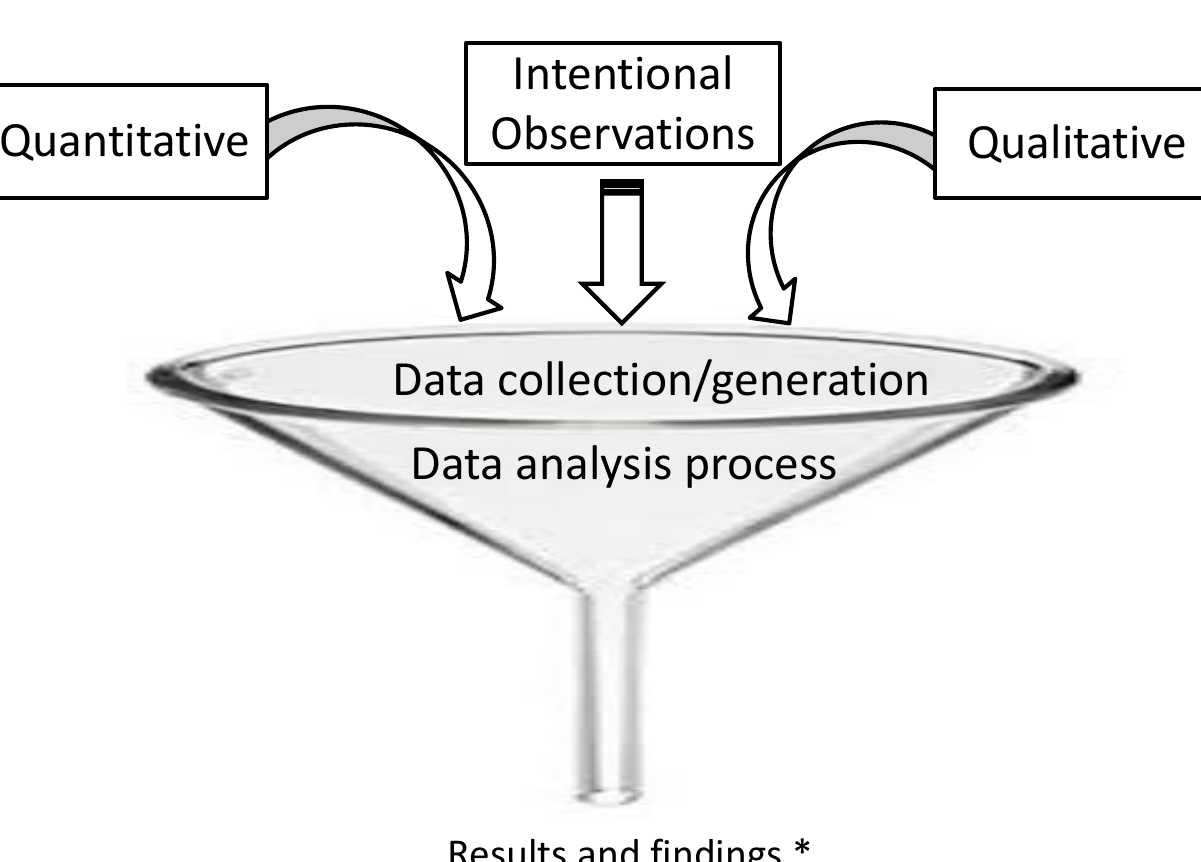
Figure 1. Illustrating the concurrency between three data collection/generation modes of the IOCRD. * Integrated findings are coming out from the spout of the funnel. The IOCRD is the output of integration of intentional observation to collect/generate data. This output produces the